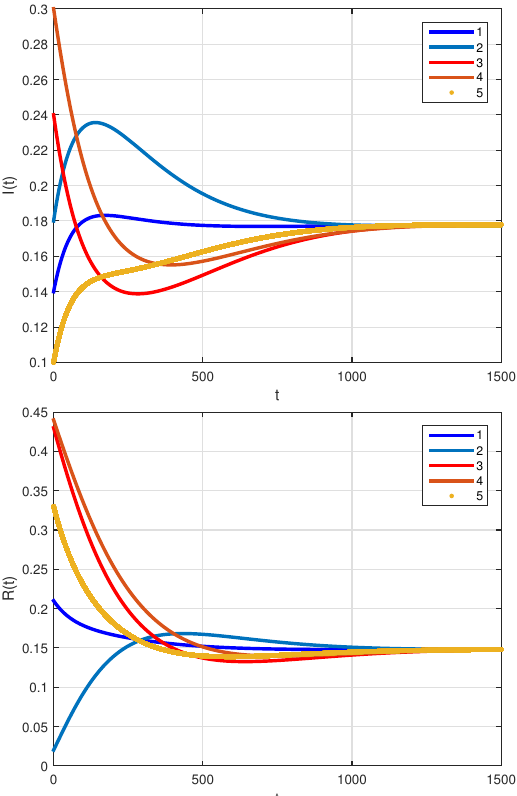
Figure 8. The evolution dynamics of infected and removed population against time, using initial state values and R 0 = 2.1429 >